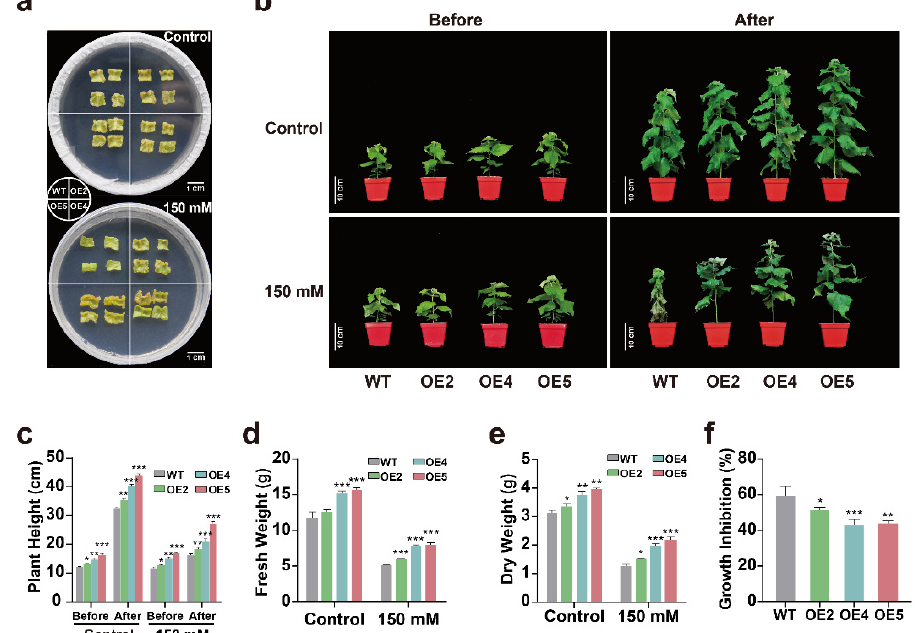
Figure 5. Overexpression of PtGSTF1 enhanced salt tolerance in transgenic plants. ( a ) Callus induction analysis. Leaf explants from four-week-old wild type (WT) and PtGSTF1 transgenic plants were cultured on callus induction medium supplemented with 0 (control) or 150 mM NaCl for 1 week. ( b ) Growth phenotypes of WT and transgenic plants. Four-week-old plants grown in a greenhouse were treated with 0 (control) or 150 mM NaCl for another 4 weeks. ( c – f ) Plant heights, fresh and dry weights, and growth inhibitions before and after the salt treatment. WT, wild type; OE2, OE4 and OE5, different transgenic lines. Values are the mean ± SD from three independent experiments ( n = 3). *, p < 0.05; **, p < 0.01; ***, p < 0.001.